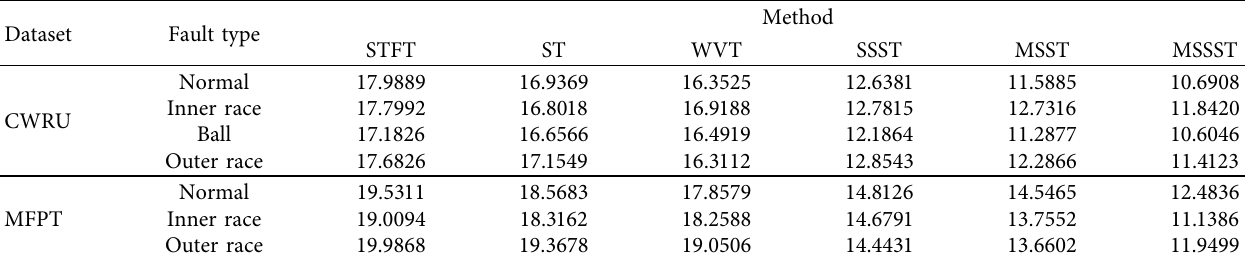
Table 3: R´enyi entropy of different frequency analysis